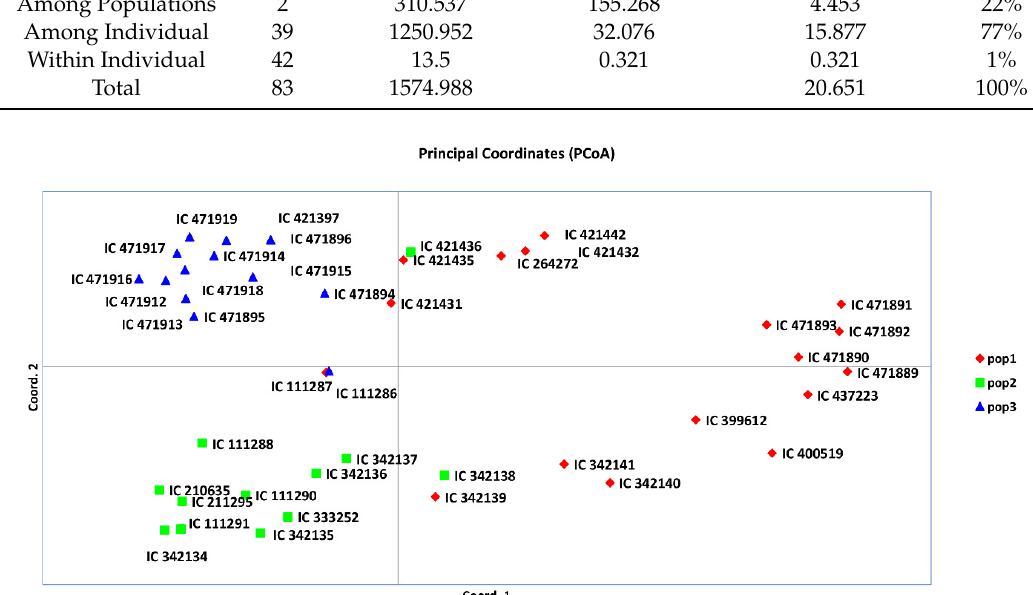
Table 4. Summary of analysis of molecular variance of 41 genomic SSRs among 42 Kalmegh accessions.